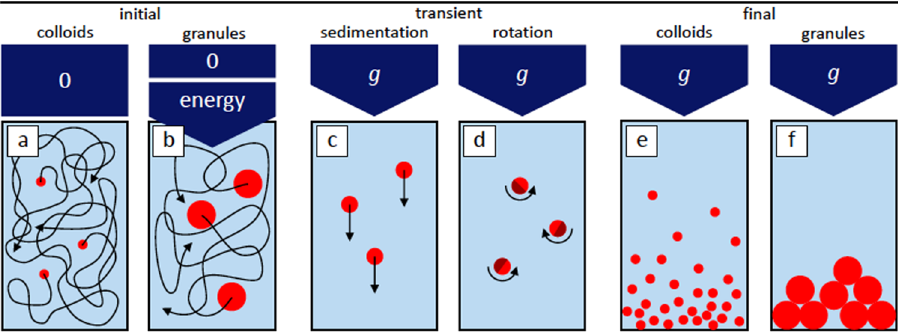
Fig. 2 Effect of gravity on colloidal particles. Schematic representation of some key effects of gravity on small (colloidal) or large (granular) particles in a fl uid. a In the absence of gravity, thermal fl uctuations lead to a uniform distribution of colloidal particles. b For granular particles this process can be prohibitively slow, and hence injection of mechanical energy is required for the system to remain in a fl uid state. c Gravity promotes a net fl ux of particles (sedimentation) along the direction of gravity. d If the mass distribution within each particle is not spherically symmetric, gravity results in a net torque on the particles, which can promote their orientational ordering. e For a diluted colloidal suspension, the steady-state distribution of particles in the presence of gravity is not homogeneous along the direction of gravity but corresponds to an exponential concentration pro fi le. f In a granular medium, the particles densely accumulate at the bottom of the container, where they minimize their gravitational potential energy and form load-bearing frictional